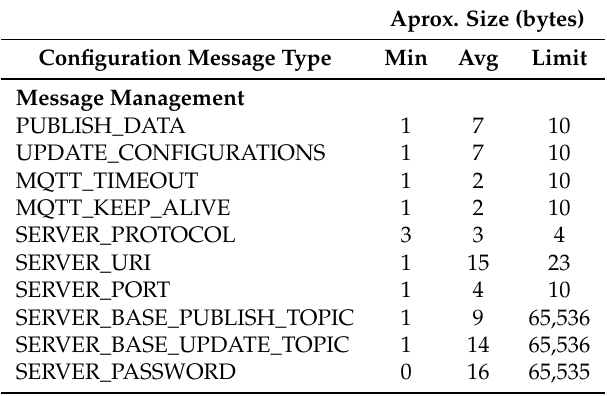
Table 6. Configuration message size analysis—message